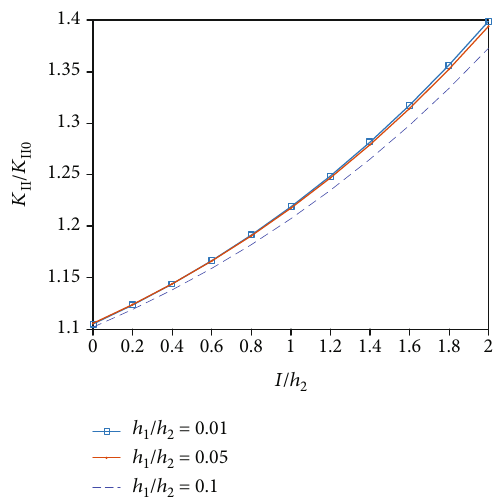
Figure 7: E ff ects of l / h for di ff erent h